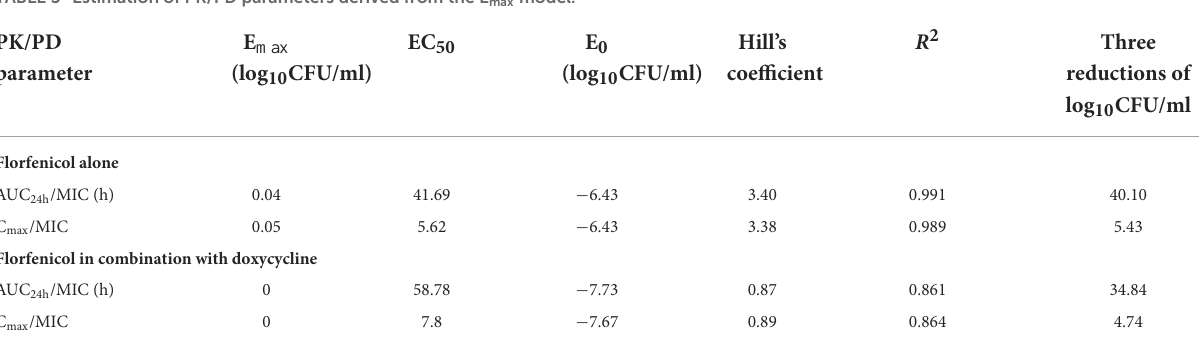
TABLE 3 Estimation of PK/PD parameters derived from the E max